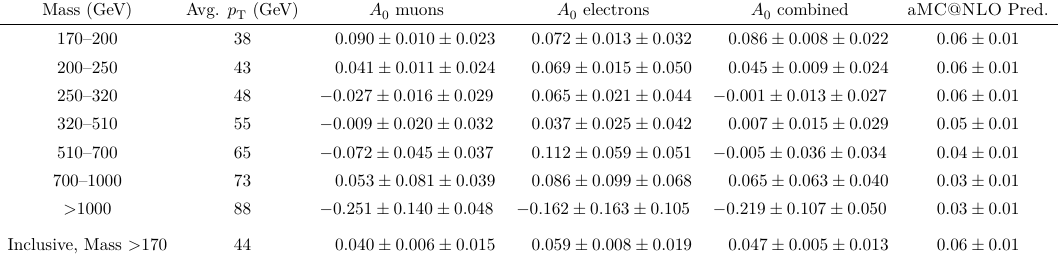
from the maximum likelihood fit to data in different Table 3 . Results for the measurement of A 0 dilepton mass bins in the different channels as well as an inclusive measurement across all mass bins. The first and second uncertainties listed with each measurement are statistical and system- atic, respectively. The last columns lists the predictions of A and associated uncertainties from 0